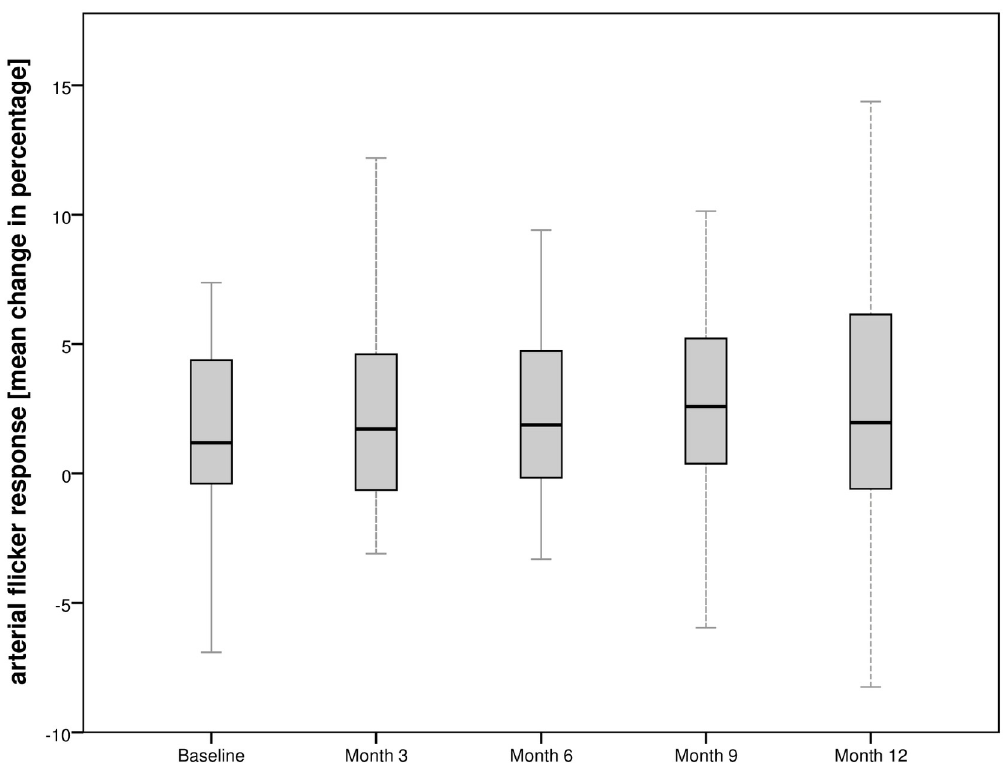
Fig 4. Course of arterial flicker response for the total population undergoing intravitreal aflibercept injections over the observational period.